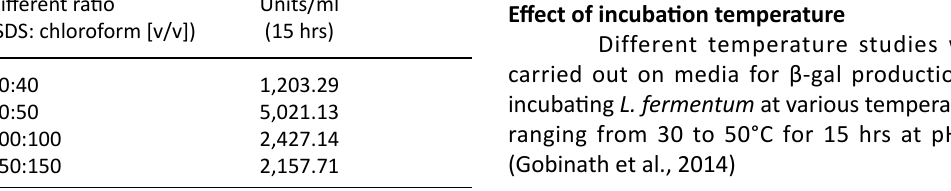
Table 2. Permeabilizing agent used and its enzyme activity Different ratio